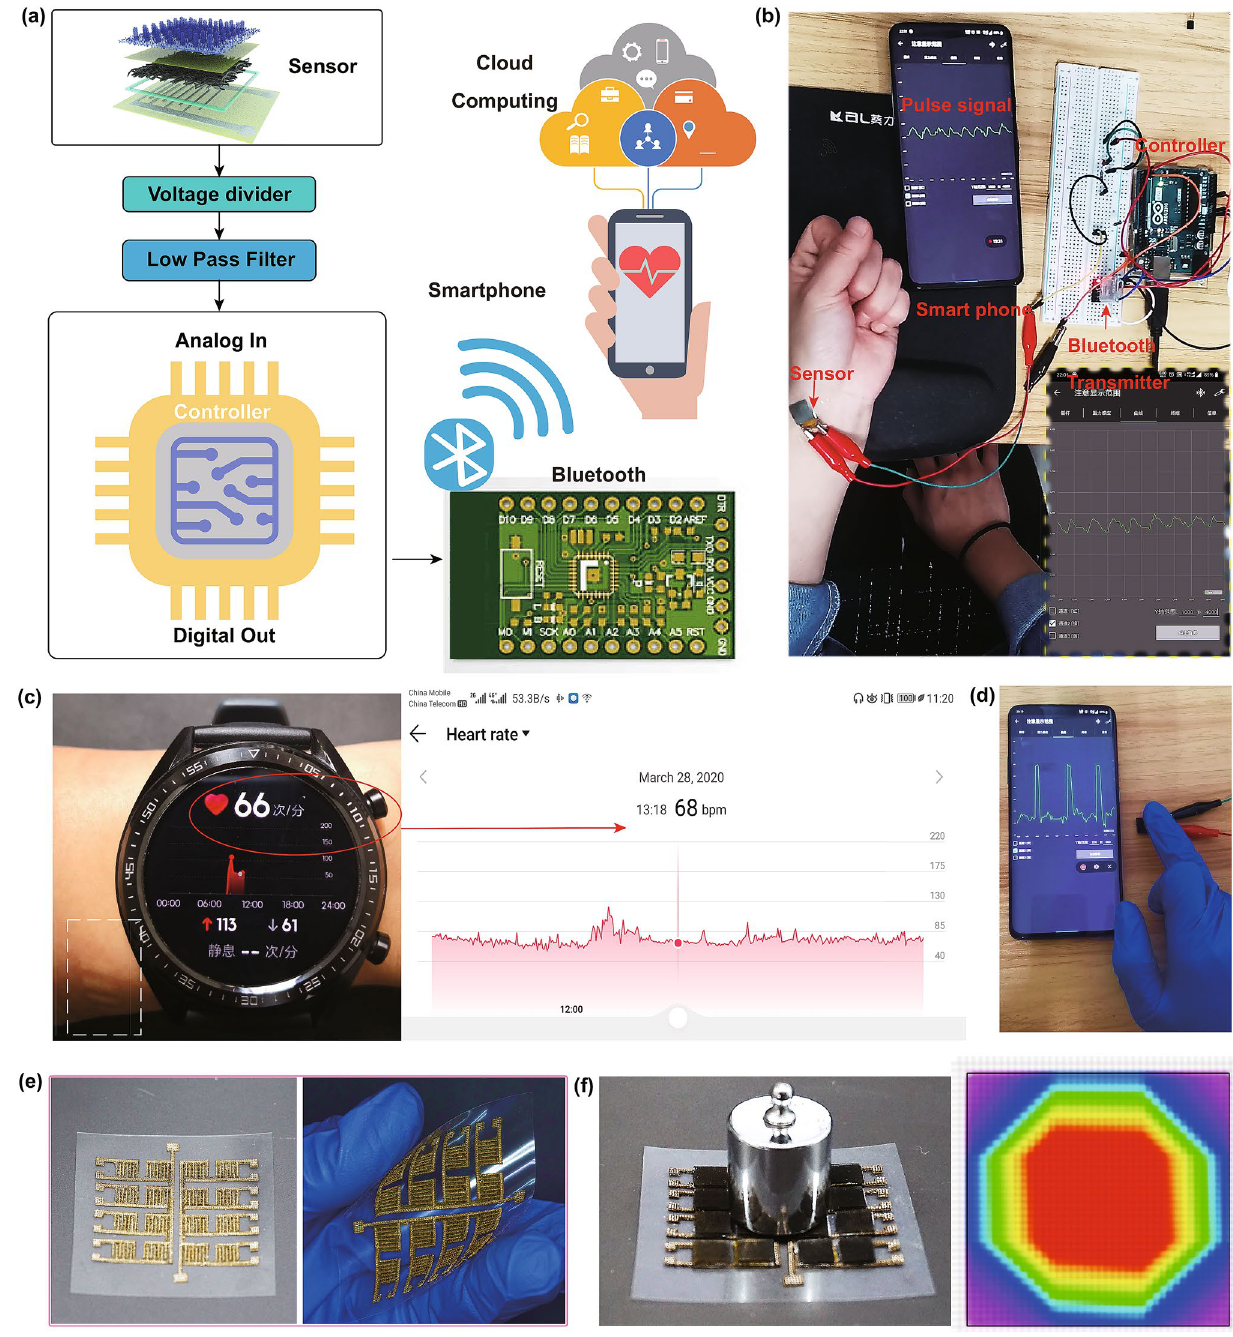
Fig. 6 Wireless real‑time pulse monitoring of the sensor for healthcare. a Device configuration of the wearable sensor system. b Practical appli‑ cation of detecting the pulse wave and successfully send the signal to the smartphone. c Commercial sports watch showed a similar date value collected by our wearable sensor. d Practical application of gentle touching. e 4 × 4 sensor array and its corresponding highly flexible circuit dia‑ gram. f Pressing geometrical area of the weight measured by the sensor